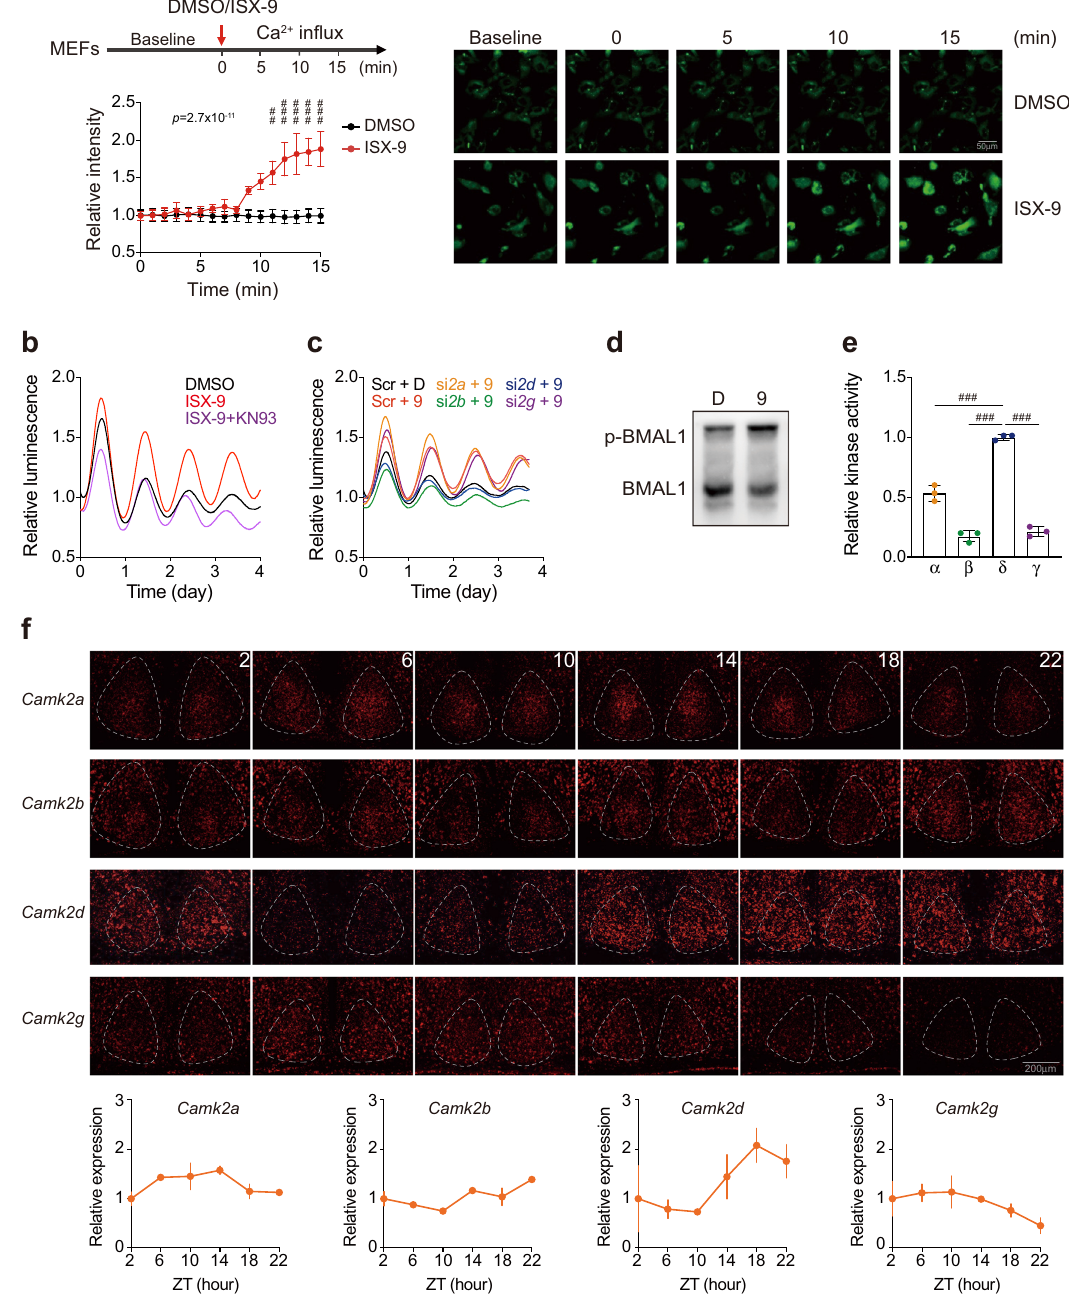
Fig. 5 ISX-9 triggered Ca 2 + in fl ux and BMAL1 phosphorylation in a CaMKII δ -dependent manner. a Assay scheme for the Ca 2 + in fl ux measurement (left), and Fluo-4 AM fl uorescence change upon DMSO (black curve) or 10 μ M ISX-9 (orange curve) treatment in MEF cells. Representative images were shown at indicated time points (right). Scale bar, 50 μ m. Two-way ANOVA with Bonferroni correction for multiple comparison was performed, with p value labeled on top. Signi fi cances between DMSO and ISX-9-treated cells in each time point were shown (## p < 0.01, ### p < 0.001), and data were shown as mean ± SD. b PER2::LUC oscillations under DMSO (black curve), ISX-9 (red curve), and ISX-9 with CaMKII inhibitor KN93 (magenta curve) treated conditions. c PER2::LUC oscillations under DMSO, ISX-9, and individual knockdown of Camk2a , Camk2b , Camk2d, and Camk2g with ISX-9 treatment. d Phos- tag gel analysis for BMAL1 phosphorylation level in DMSO (D), or 10 μ M ISX-9 (9) treated MEF cells. e Puri fi ed CaMKII α , β , γ , and δ were subjected to in vitro kinase assay using puri fi ed BMAL1 as the substrate. The highest activity was set as 1 to facilitate comparison among isoforms. One-way ANOVA with Bonferroni correction for multiple comparison was performed (### p < 0.001), and data were shown as mean ± SD. f Single-molecule RNA fl uorescence in situ hybridization of CamK2a, b, d , and g in the SCN from male 2-month-old wild-type mice ( n = 3) at indicated zeitgeber time. Expression levels in SCN were quanti fi ed and normalized to the fi rst time point as 1, data are shown as mean ±